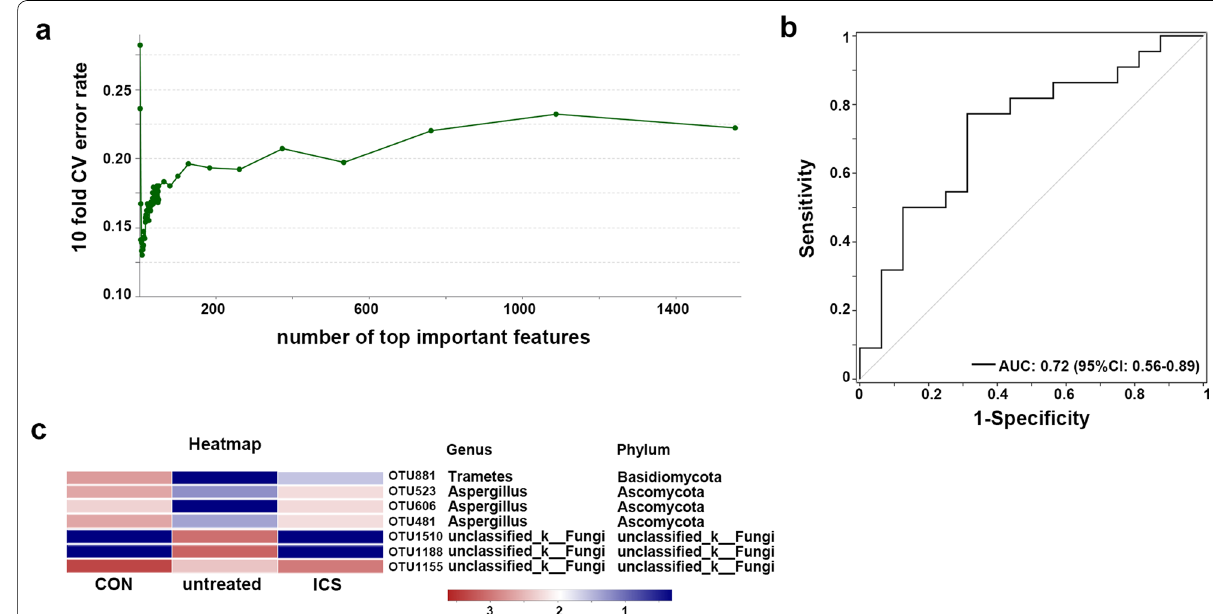
Fig. 3 Biomarkers detected in airway mycobiome and comparisons of these biomarkers. a Prediction models using Random Forest (RF). X-axis represents the number of important species (variables) ranking top n, y-axis represents the corresponding prediction error rate using ten-fold cross validation (CV). b The Receiver Operating Characteristic (ROC) curve for the random forest model using the 7 OTUs. c The heat map showed the relative abundance of these biomarkers (mycobiome) in different